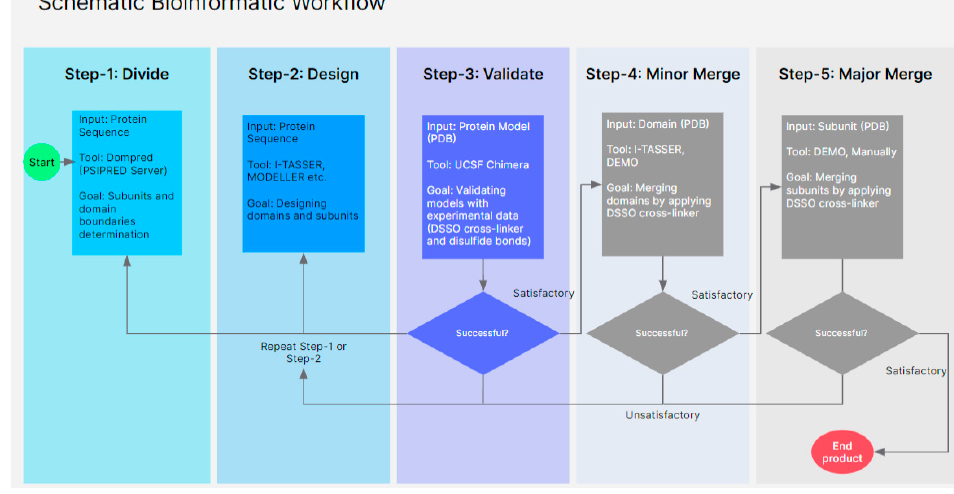
Figure 10. Brief depiction of a “divide and conquer” workflow applied to apoB-100 and related structures.